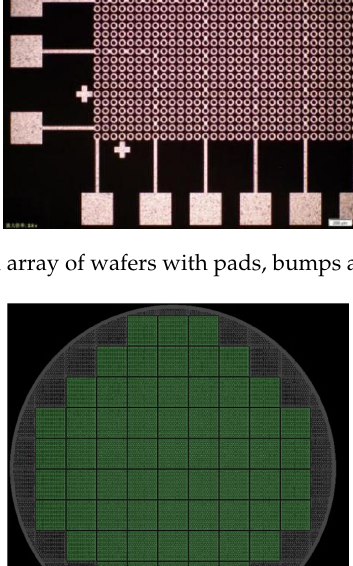
Figure 7. Distribution of the whole die scanned by automated optical inspection (AOI). Micromachines 2020 , 11 , x FOR PEER REVIEW